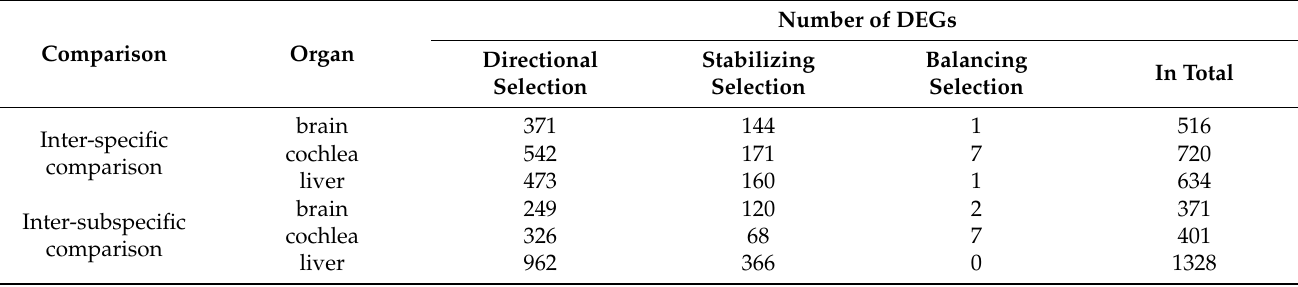
Table 1. Numbers of differentially expressed genes (DEGs) with expression variation forced by natural selection in the inter-specific and inter-subspecific comparisons for three organs.